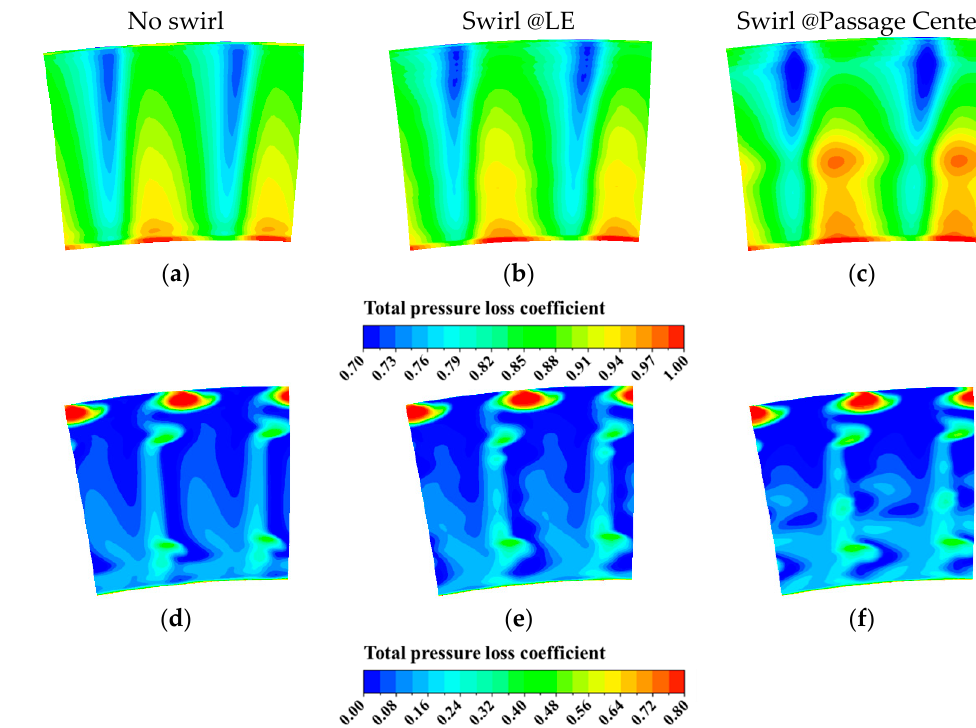
Figure 25. Total pressure loss coefficient at the inlet and exit of blade (rear view), Baseline NGV: ( a ) Blade inlet, No swirl; ( b ) Blade inlet, SW@LE; (c) Blade inlet, SW@PC; ( d ) Blade exit, No swirl; ( e ) Blade exit, SW@LE; ( f ) Blade exit, SW@PC